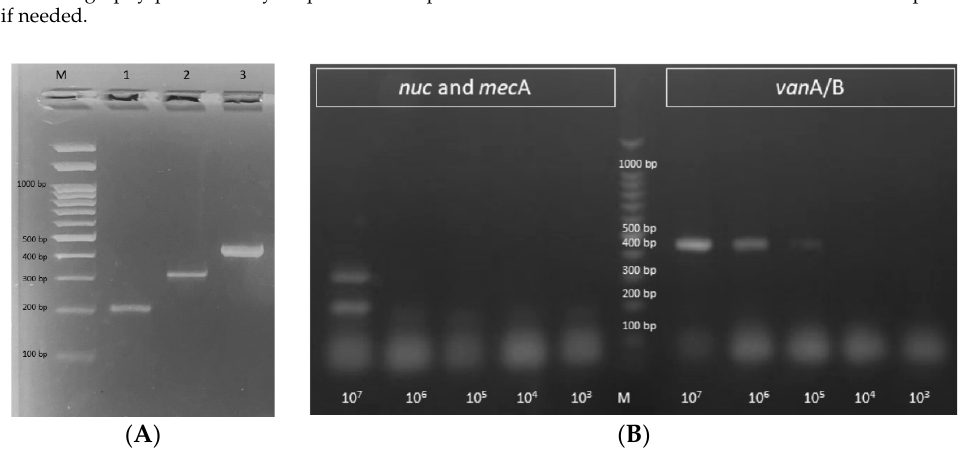
Figure 2. Agarose gel visualization of the amplification products of the developed: ( A ) uniplex PCR, where: M is a 100 bp DNA ladder, lanes 1–3 show the amplification products of nuc , mec A, and van A/B genes with the expected product sizes of 192, 310, and 420 bp, respectively, and ( B ) mPCR performed on the genomic DNA extracted from different dilutions of S31 and E25 (from 10 7 to 10 3 CFU/mL). It successfully detected S. aureus ( nuc ; 192 bp) and methicillin resistance ( mec A; 310 bp) with a LODs of 10 7 CFU/mL and vancomycin resistance ( van A/B; 420 bp) with an LOD of 10 5 CFU/mL. M: 100 bp DNA ladder.